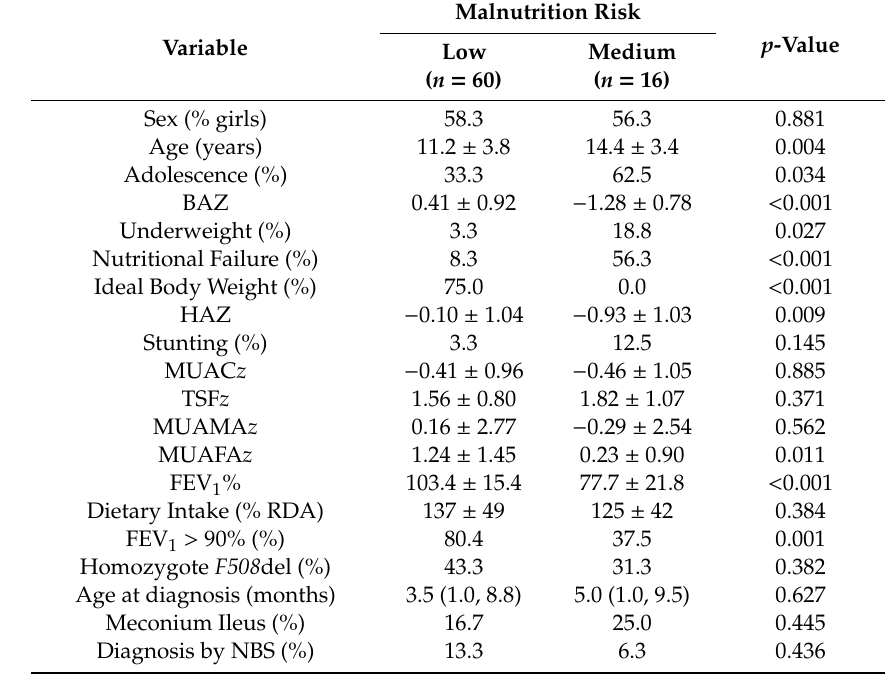
Table 2. Associations between anthropometry and clinical parameters, by malnutrition risk strata ( N =